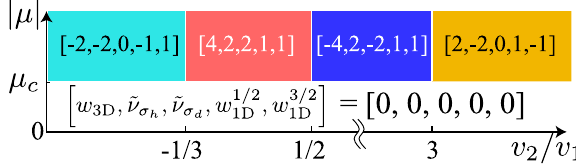
FIG. 11. Topological phase diagram of the A 1 m 0 α < 0 . The other conditions are the same as in Fig.